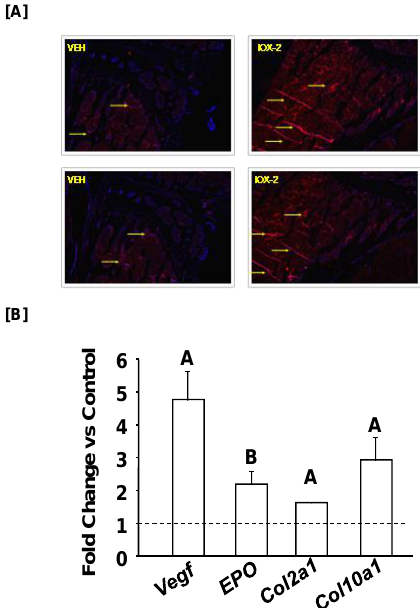
Figure 3. Expression patterns of pericytes and bone markers in response to IOX2 treatment. ( A ) Expression of pericyte markers by immunohistochemistry at the injured site of control mice treated with IOX2 or vehicle and ( B ) Three days treatment of IOX2 increased expression of angiogenesis and endochondral bone markers in pericytes. Values are mean ± SEM. Arrows show expression (red) of NG2 and PDGFRβ. A p < 0.05; B p = 0.08 vs. vehicle control.